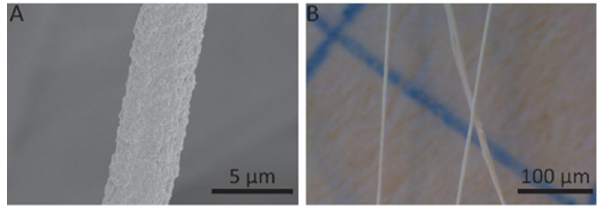
Figure 6. SEM images of other fibers spun with the microfluidic spinneret. ( A ) PVA fiber. ( B ) PAN fiber.